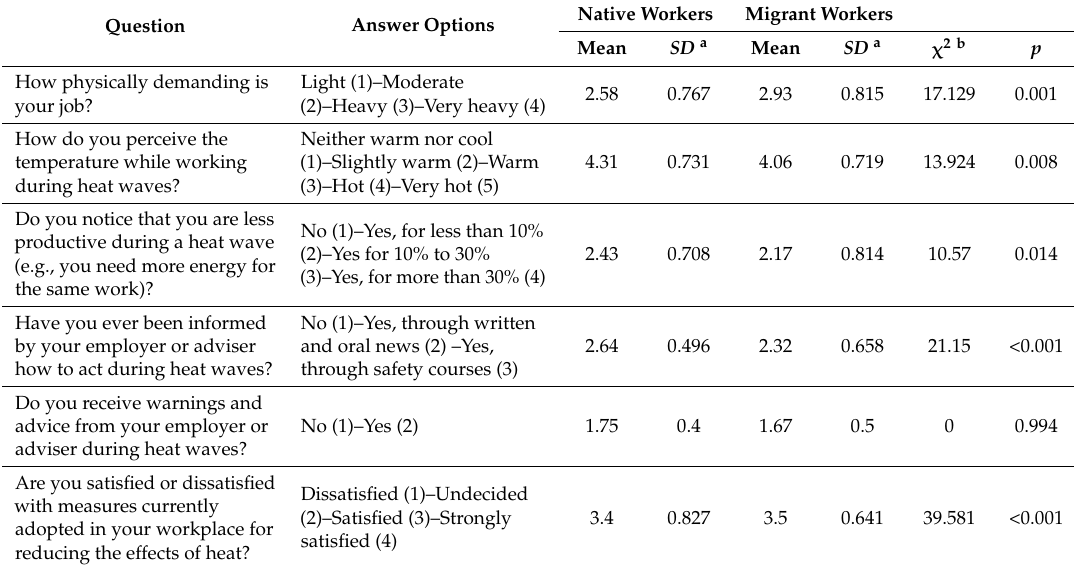
Table 3. Chi-squared analysis results of the first part of the questionnaire submitted to